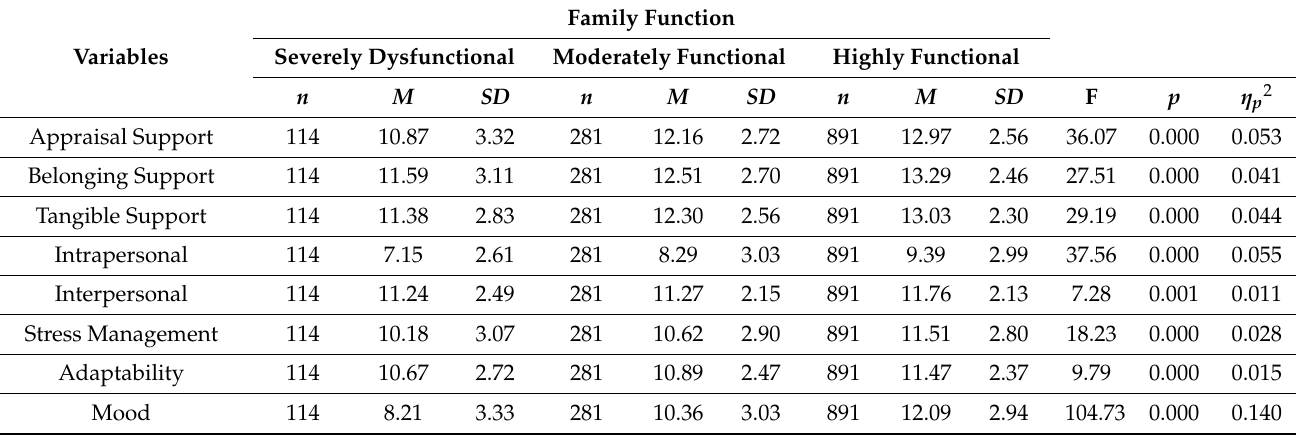
Table 4. Means and standard deviations corresponding to the Family Function Groups (IV) in the interpersonal support and emotional intelligence